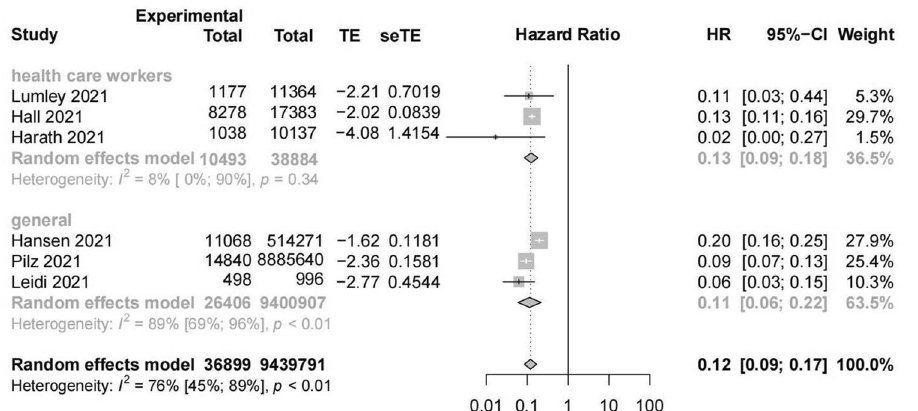
Figure 2. Forest plot of association between previous infection and SARS-CoV-2